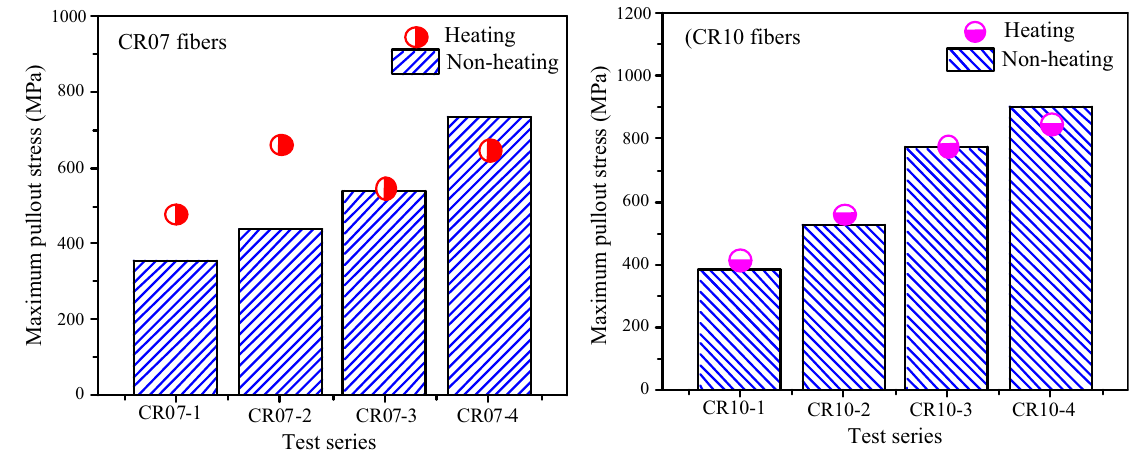
Figure 7: Maximum pullout stress of crimped fi bers with and without heating.